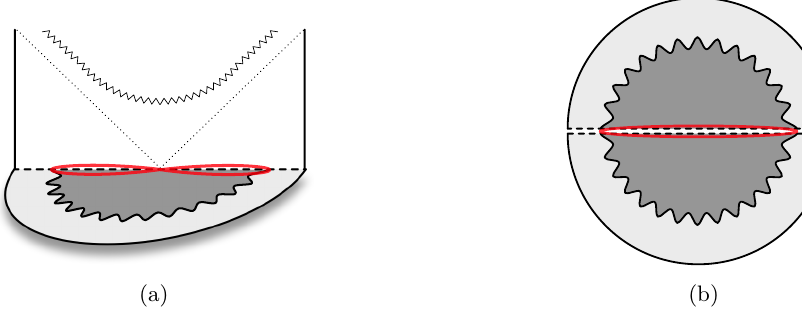
Figure 10 . The Infinitesimal Duality . When the SL(2 , R ) k / U(1) or Z \ SL(2 , C ) k / SU(2) Euclidean black hole CFT is deformed by a marginal operator known as the sine-Liouville operator — so-called because its free-field limit is the sine-Liouville potential — a condensate of strings that wrap the Euclidean horizon is introduced (right). The red loop is a spatial slice of string, corresponding to the image of the dashed line in figure 7a bounding the worldsheet TFD state with a pair of winding insertions. It may be thought of as a pair of folded strings emanating from the horizon, contrasted with the disconnected folded strings emanating from the strong-coupling region in the EPR description (figure 6b and 7b). When continued to the Lorentzian ER string theory, one finds a pair of folded strings joined at the horizon bifurcation point in an entangled state. The deformation introduces a condensate of such strings, and the infinitesimal duality asserts that the same effect is described by shifting the constant mode of the dilaton. In both descriptions the mass of the black hole is in turn